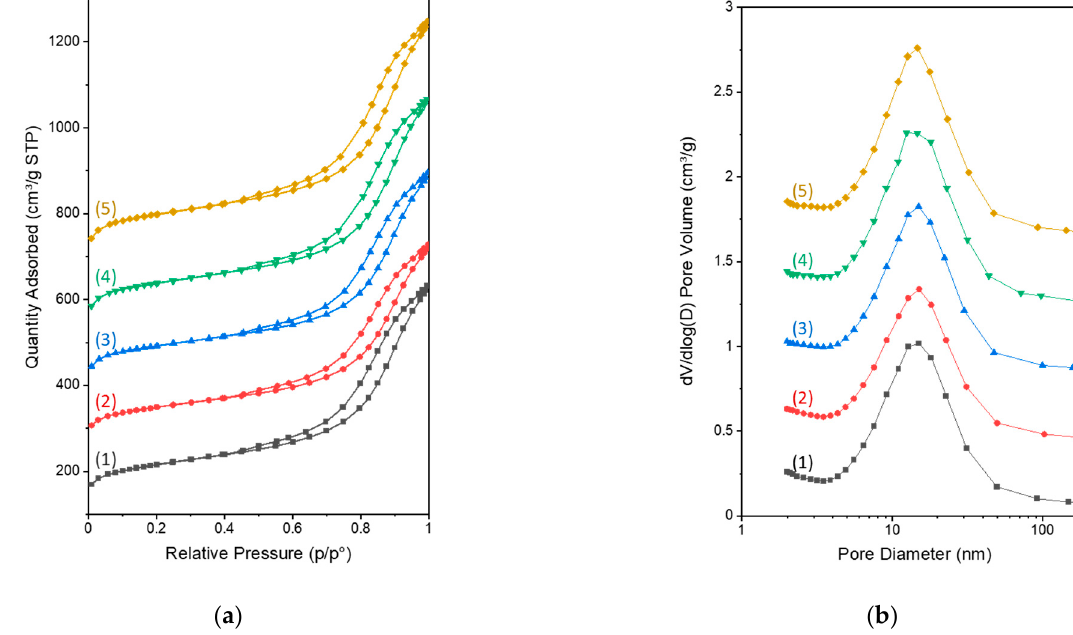
Figure 5. Nitrogen physisorption analysis of MC-ox samples: (1) MC-ox, (2) MC-ox200, (3) MC-ox400, (4) MC-ox600, and (5) MC-ox800. ( a ) adsorption-desorption isotherms; offsets of 150, 275, 400, and 550 cm 3 /g were applied to the isotherms (2)–(5), respectively; ( b ) pore size distributions (PSD) calculated using the BJH model; a constant 0.4 cm 3 /g offset was applied between the PSDs.